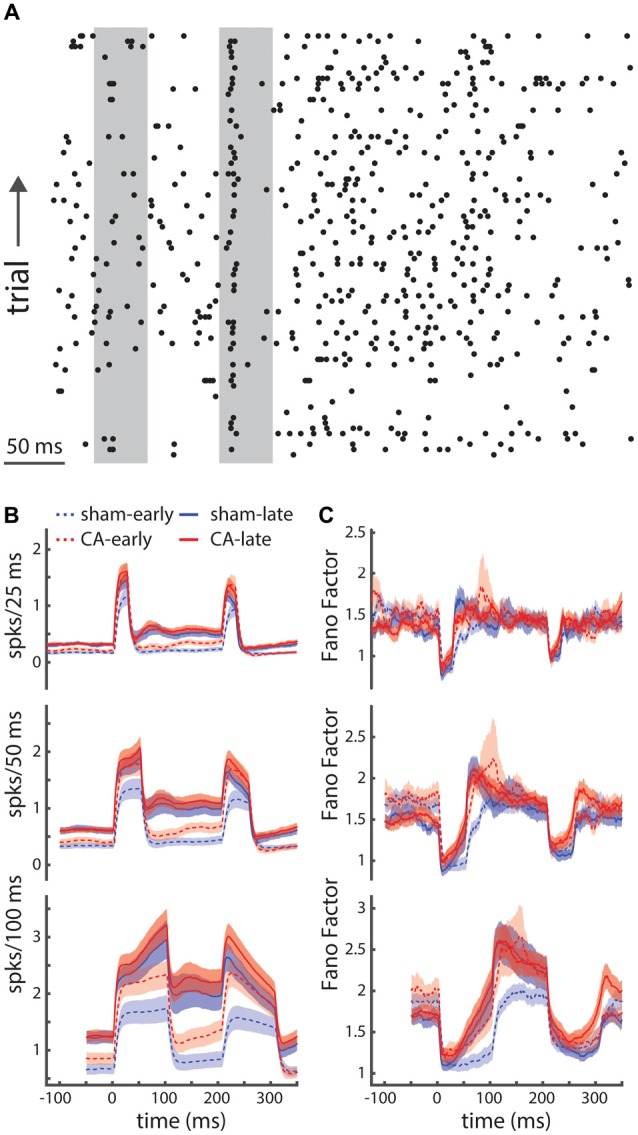
Relative spike-count variability is unique for early sham rats. (A) A spike raster plot displaying the relatively high trial-to-trial variability of thalamocortical neurons in the ventral posterior medial (VPm) nucleus. (B) Time dependent firing rates are calculated by convolving spike counts with sliding square-wave windows of different widths (25 ms, 50 ms and 100 ms; top-bottom). (C) The time-dependent Fano factor (spike count variance divided by mean count), using different counting windows (top-bottom: 25 ms, 50 ms, 100 ms), reveals stimulus dependent reduction in spike count variability. Using a large counting window (100 ms) we are better able to estimate the Fano factor and start to see systematic differences in the pattern of relative variability of sham-early spiking activity compared to other groups: both CA-early and late groups. Shaded regions indicate s.e.m.